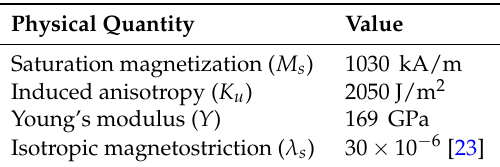
Table 1. Material parameters used for the modified SW